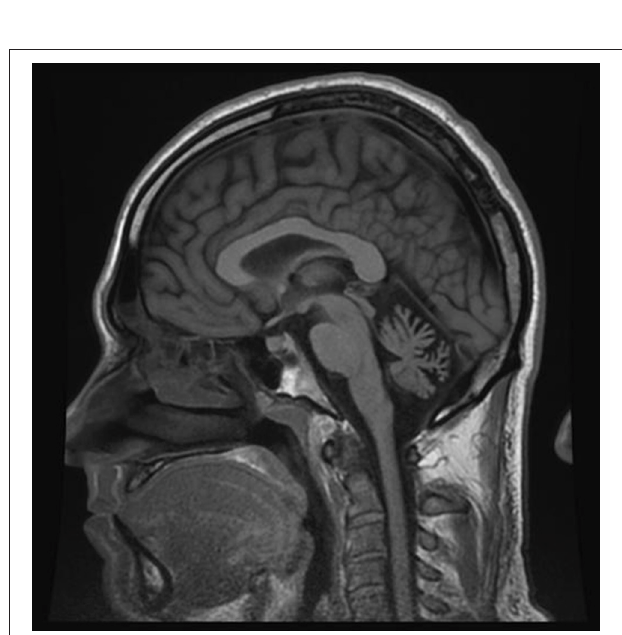
FIGURE 2 | MRI examination (T1 weighted sagittal image) of patient F. Notice severe cerebellar atrophy.